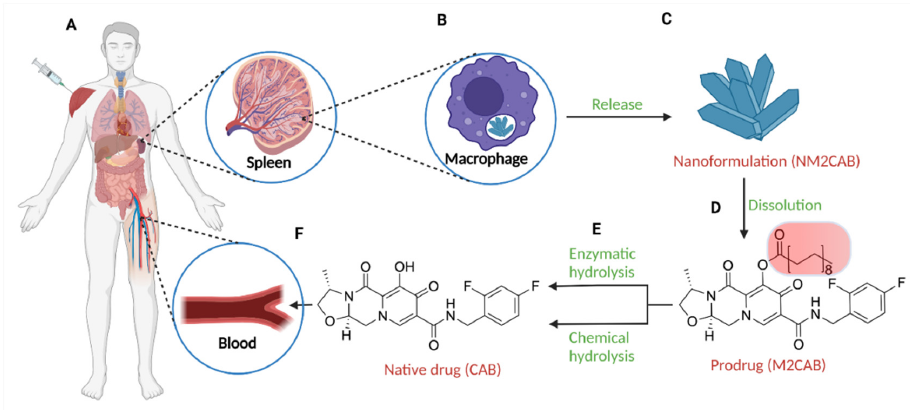
Figure 2. Mechanism for in vivo activity of LASER ART. ( A ) Intramuscular injection of cabotegravir prodrug nanoformulation (NM2CAB). ( B ) Lymphoid organs such as spleen act as secondary